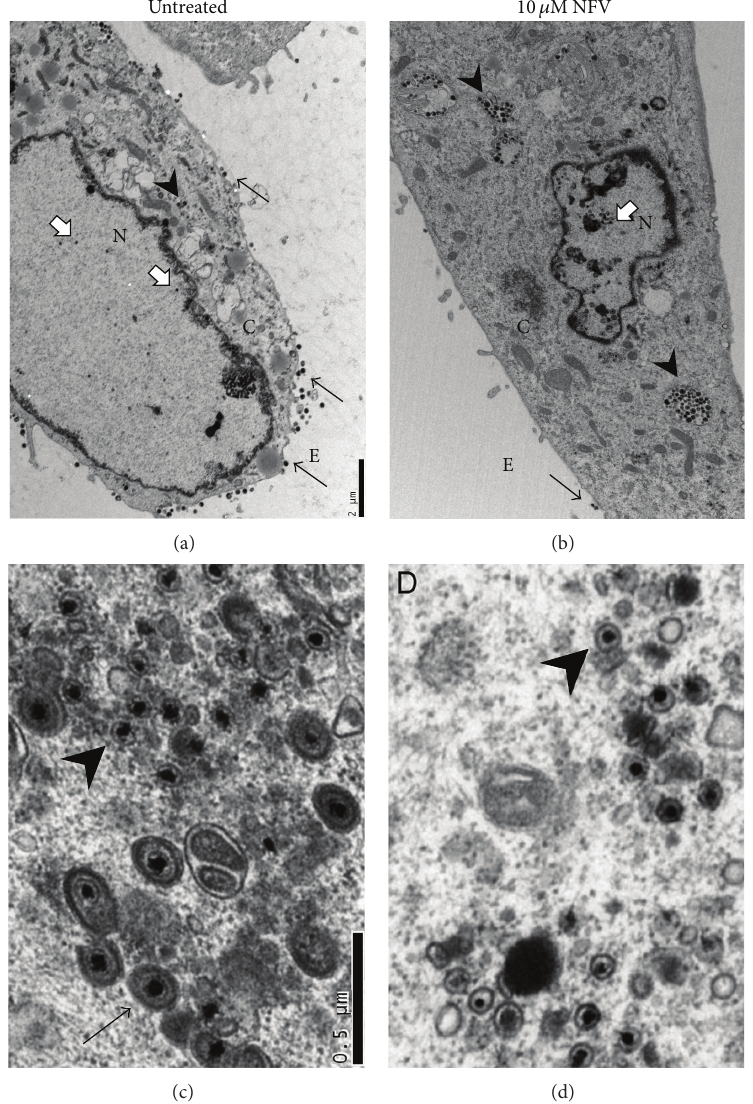
Figure 4: NFV treatment impairs HSV-1 maturation and egress. Shown are representative transmission election micrographs, performed 20 hours after HSV-1 infection of HF that were either untreated (panels (a) and (c)) or treated with 10 𝜇 M NFV (panels (b) and (d)). Low power micrographs are shown in panels (a) and (b); bar = 2 𝜇 m. White arrows indicate HSV-1 capsids in the nucleus (N), black arrowheads indicate capsids in the cytoplasm (C), and black arrows indicate extracellular (E) virions. Similar numbers of capsids were observed in the nucleus of untreated and NFV-treated cells (approximately 39 and 44, resp.). However, untreated cells were observed to have fewer capsids in the cytoplasm ( ∼ 14 versus 79) and substantially more extracellular virus particles ( ∼ 51 versus 3). Cytoplasmic virus particles are shown in panels (c) and (d); bar = 0.5 𝜇 m. Enveloped virus particles (indicated in panel (c) by a black arrow) were commonly observed in untreated cells but rarely in NFV-treated cells (approximately 9 versus 0, resp., in the fields shown). Capsids in the cytoplasm of NFV-treated cells were almost exclusively nonenveloped (indicated by arrowheads; approximately 16 versus 23 in panels (c) and (d),